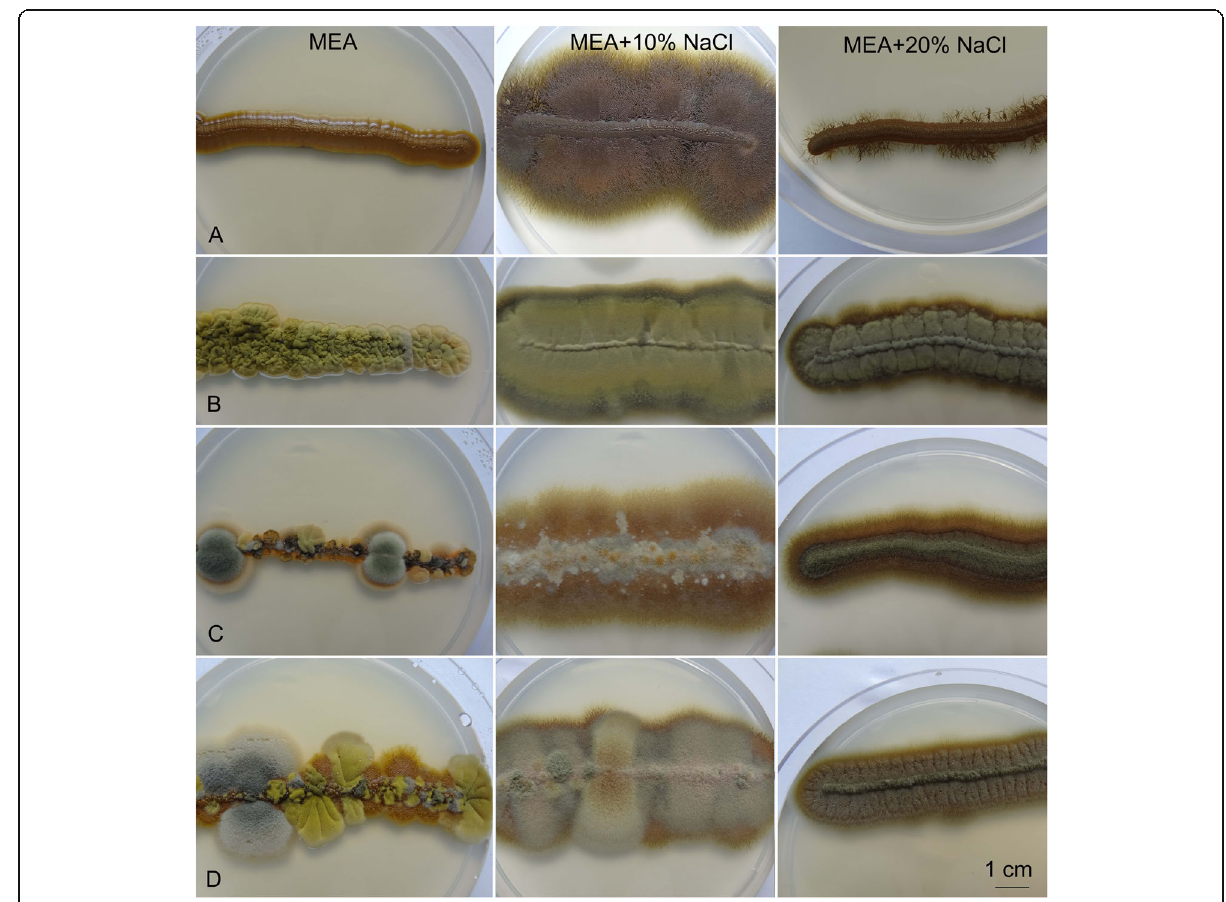
Fig. 6 Morphology of Hortaea werneckii cultures on malt extract agar (MEA) without and with added NaCl. Left: MEA; middle: MEA+ 10% NaCl; right: MEA + 20% NaCl. a EXF-120. b EXF-4717. c EXF-467. d EXF-96. Bar = 1 cm (for